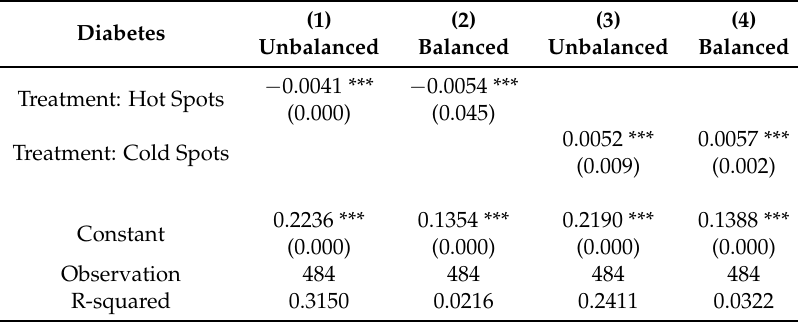
Table A3. The impacts of hot and cold spots on diabetes rates.